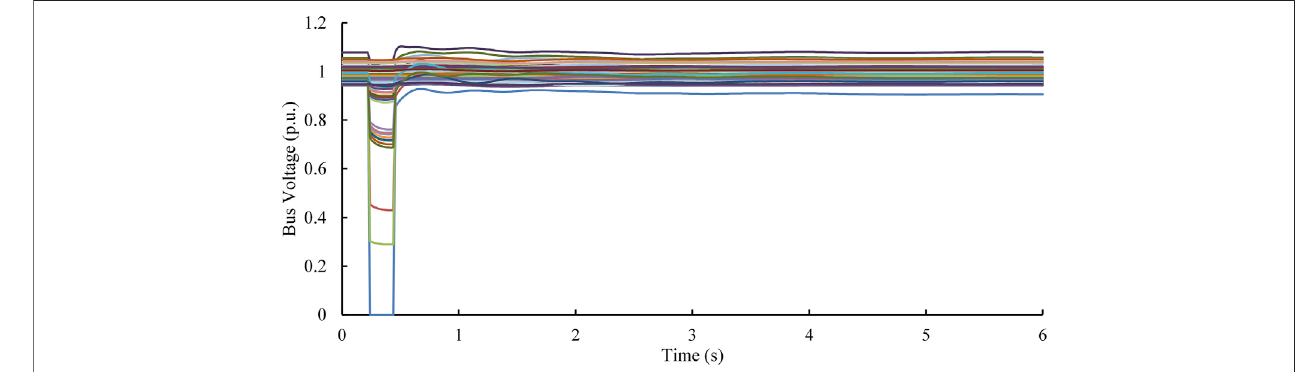
FIGURE 1 | Example of stable scenario.